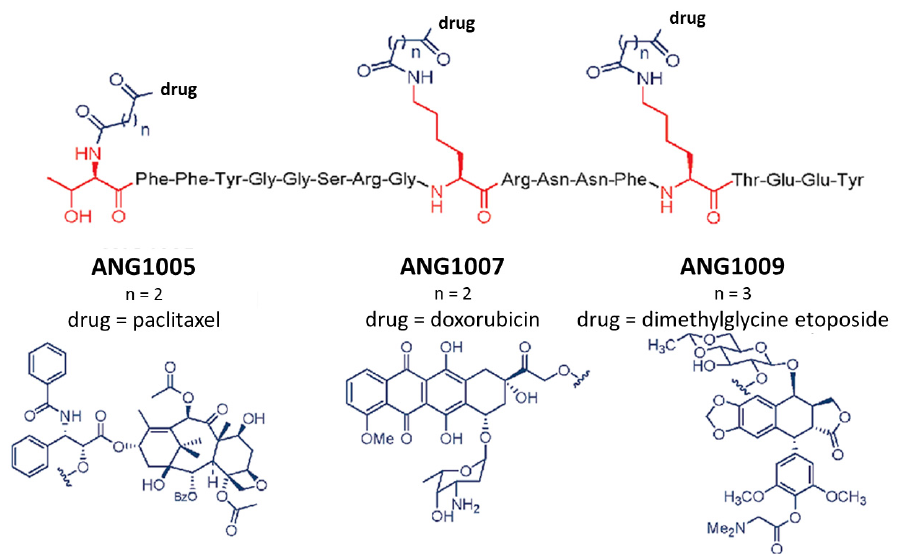
Figure 1. The structure of ANG1005, ANG1007, and ANG1009 [6]. The 3 amino acids that can be used as conjugation sites are marked in red, while the conjugated drugs with the used linkers are represented in grey.